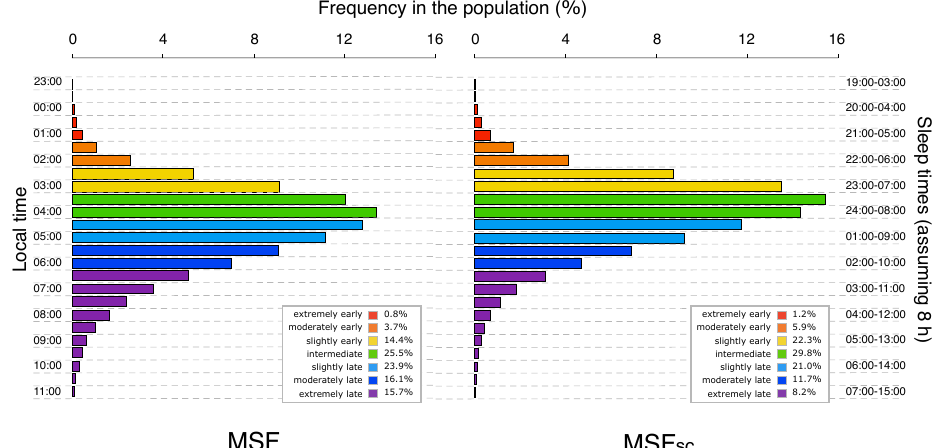
Figure 1. Distributions of midsleep on free days (MSF) (left panel) and midsleep on free days sleep corrected (MSF sc ) (right panel) in the Munich ChronoType Questionnaire (MCTQ) database (as of July 2017). The distribution is based on half-hourly bins. MCTQ entries were only included in these distributions if all questions of the core-MCTQ were answered, no alarm clocks were used on free days, and values were within a ± 3 σ range. The resulting population sizes were 221,480 for MSF and 185,333 for MSF sc (note that the latter requires information about work status and regular work schedules and is therefore smaller). Color-coding is arbitrary and classifies the population into the seven groups indicated in the legends. The left y-axis shows the local times of the midsleep values, and the right y-axis indicates the sleep window of the respective MSF group (in local time), assuming a sleep duration of eight